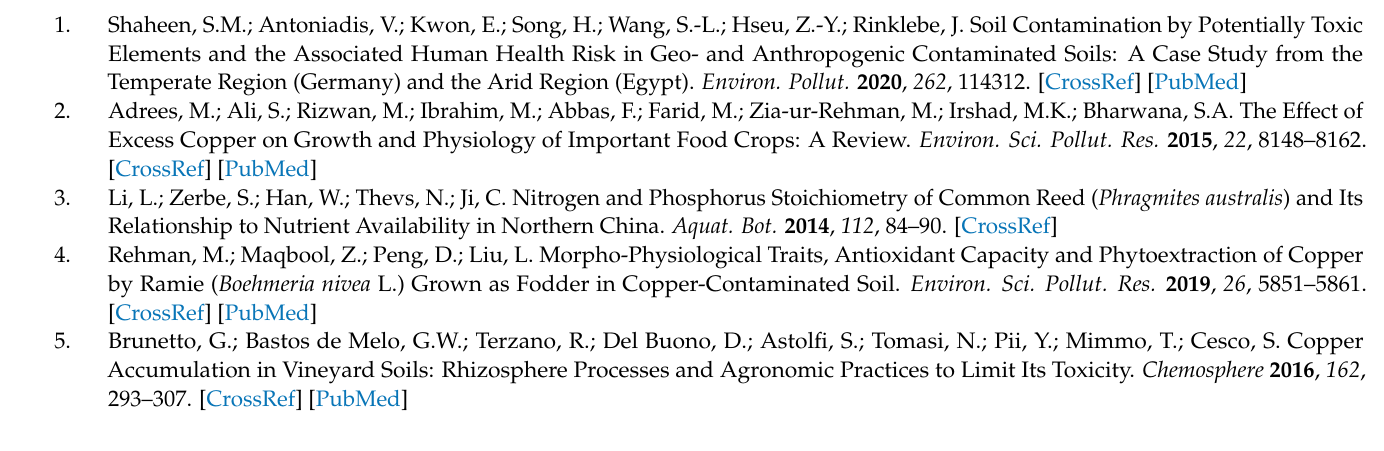
Table S6: Summary of the two-way ANOVA for C, N, and P and their corresponding stoichiometric ratios in different plant tissues as affected by species and flooding. Table S7: Summary of the two-way ANOVA for element:Cu ratios in different plant tissues as affected by species and